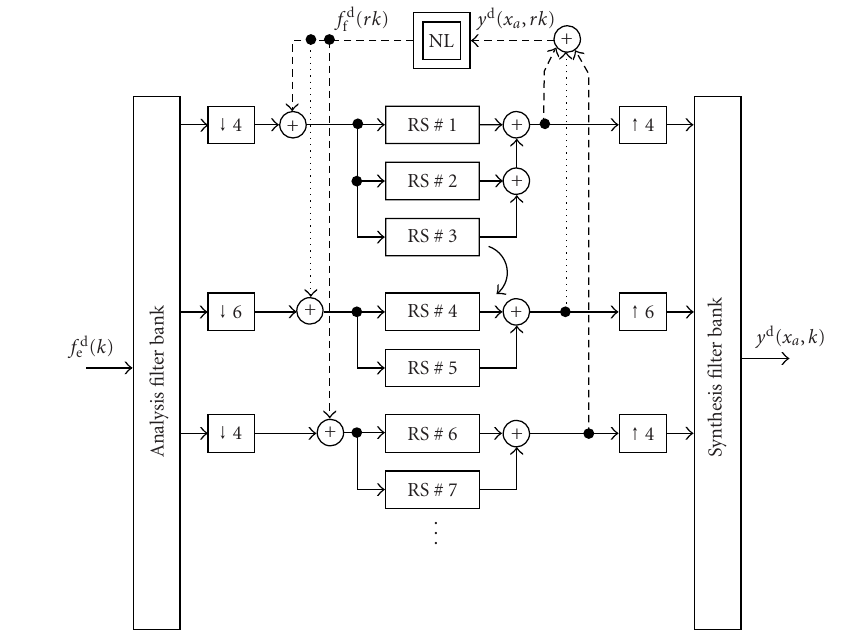
Figure 4: Structure of the multirate FTM. Solid lines represent the basic linear system, while dashed and dotted lines represent the extensions for the nonlinear slap force. RS means recursive system. The arrow between RS # 3 and RS # 4 indicates a band change.